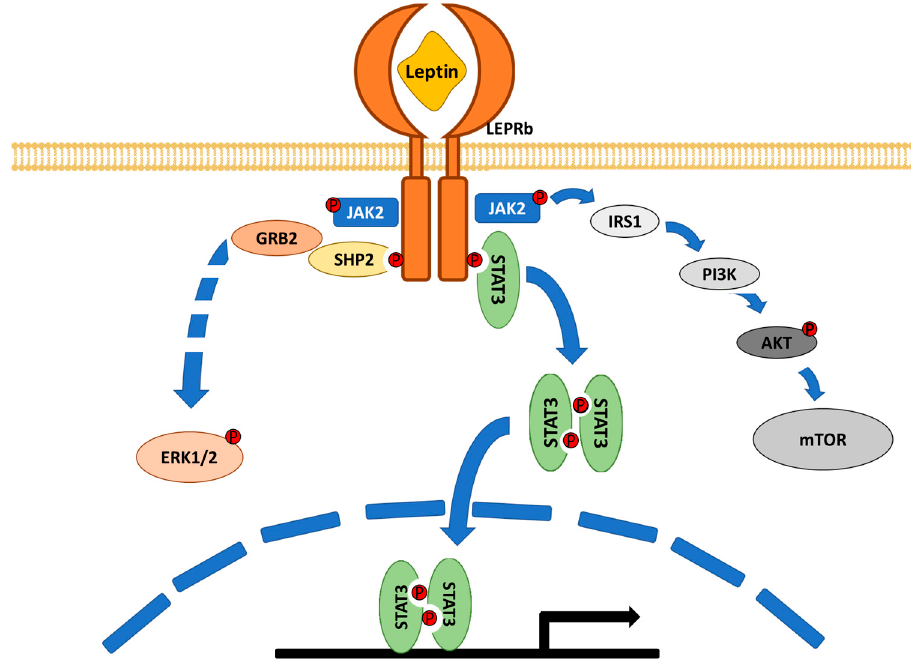
Figure 1. Schematic representation of leptin signalling. There are different isoforms of the leptin receptor, but only the long receptor (LEPRb) has shown to transduce completely the leptin signalling. Leptin induces LEPRb dimerization and phosphorylation. This receptor activation produces the activation of the JAK2/STAT3 pathway but also the activation of MAPK and PI3K